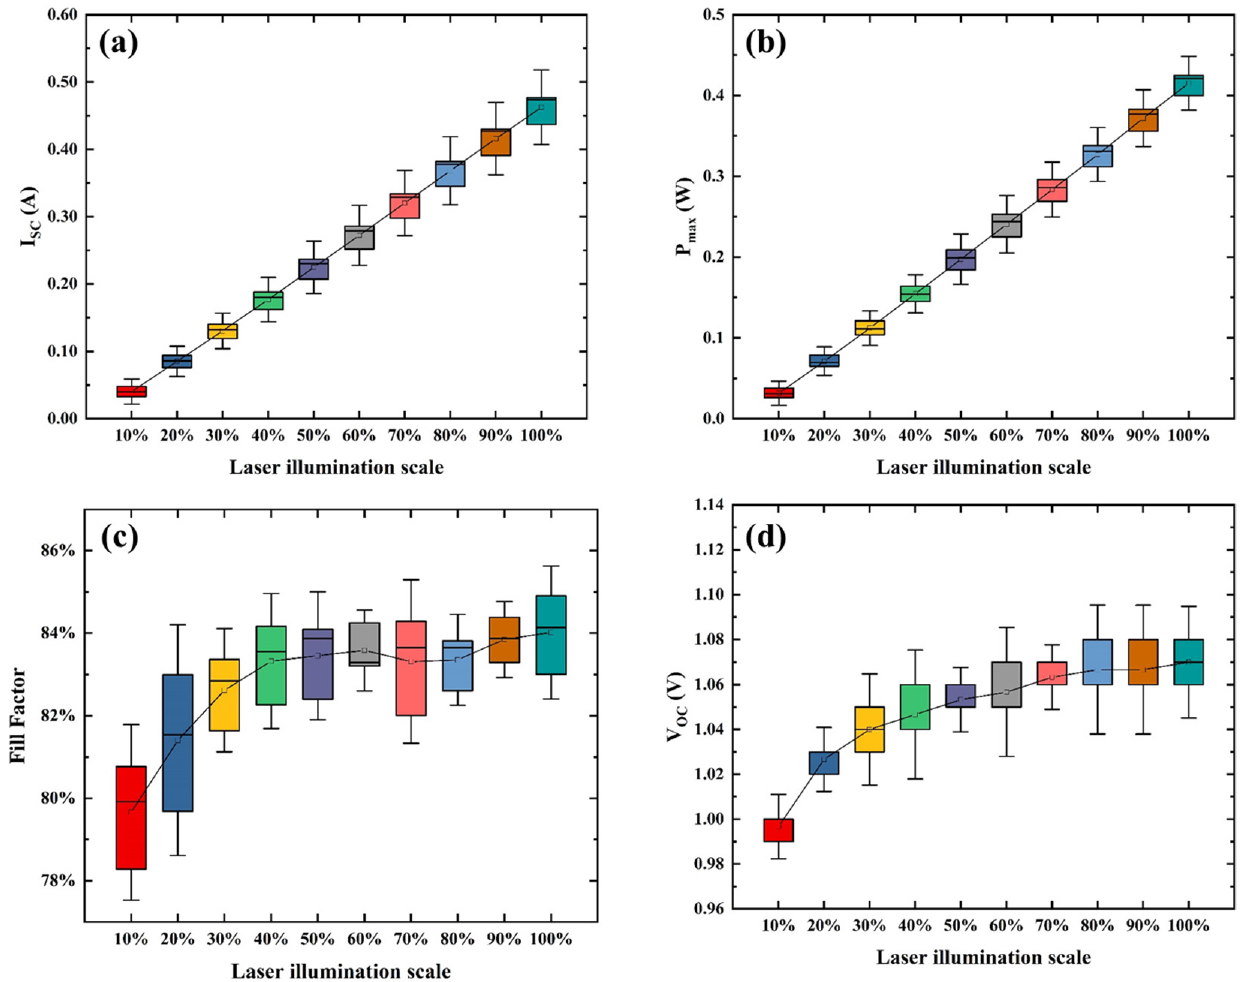
Figure 5. The relationship between the key parameters of laser photovoltaics and the proportion of area irradiation ( a ) I sc ; ( b ) P m ; ( c ) FF ; ( d ) V oc . The box defines the 25th and 75th percentiles and the median value of the set, the hollow square is the mean value, and the whiskers show the range.